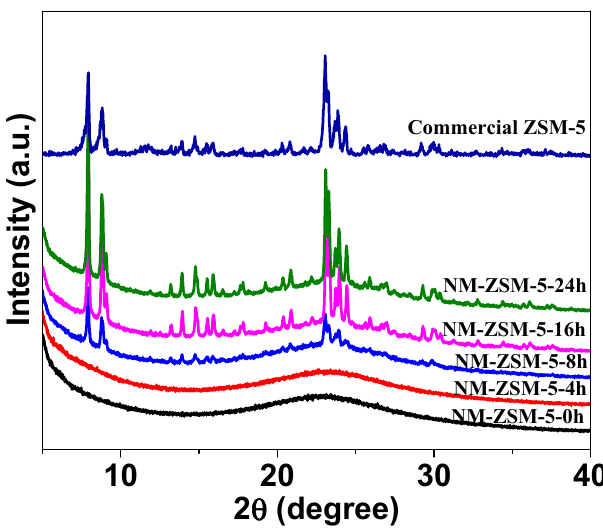
Figure 1. XRD patterns of the samples.